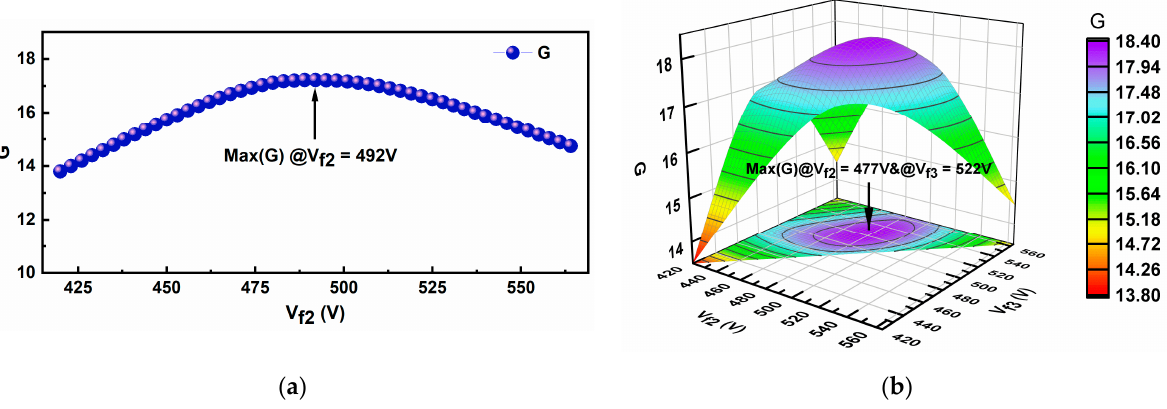
Figure 5. Optimization goal G in ( a ) double-string and ( b ) triple-string GaN LED driving